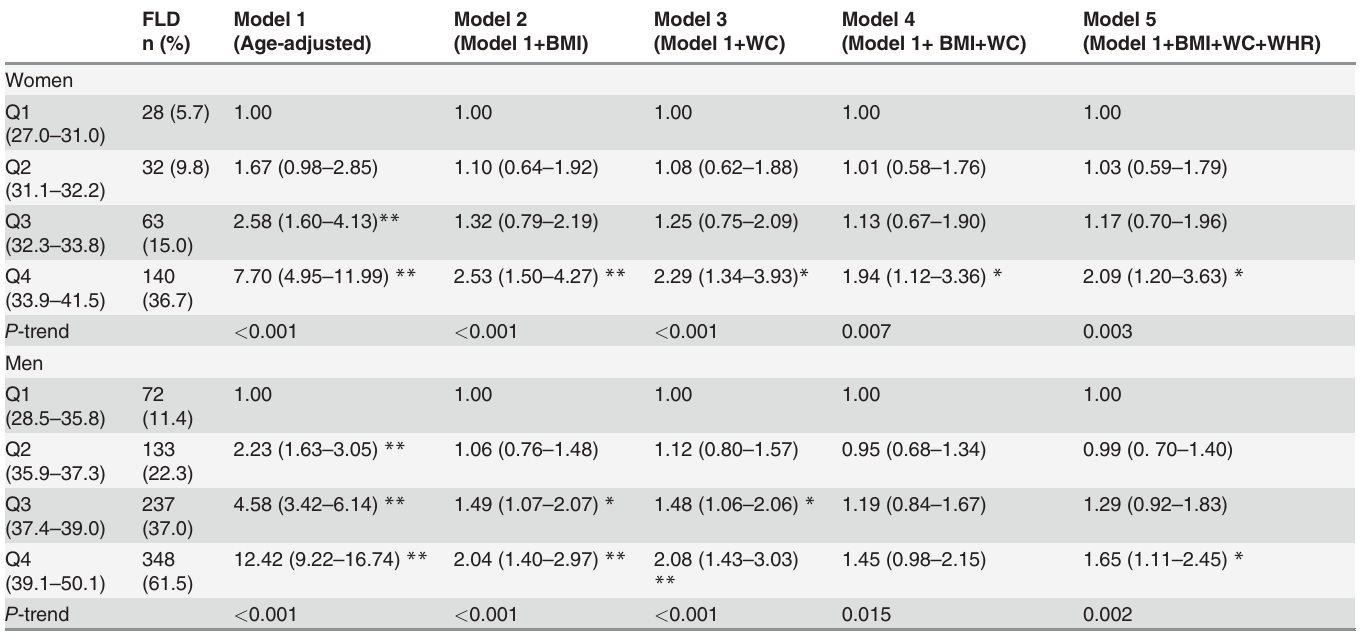
Table 2. Odds ratios of FLD by quartiles of neck